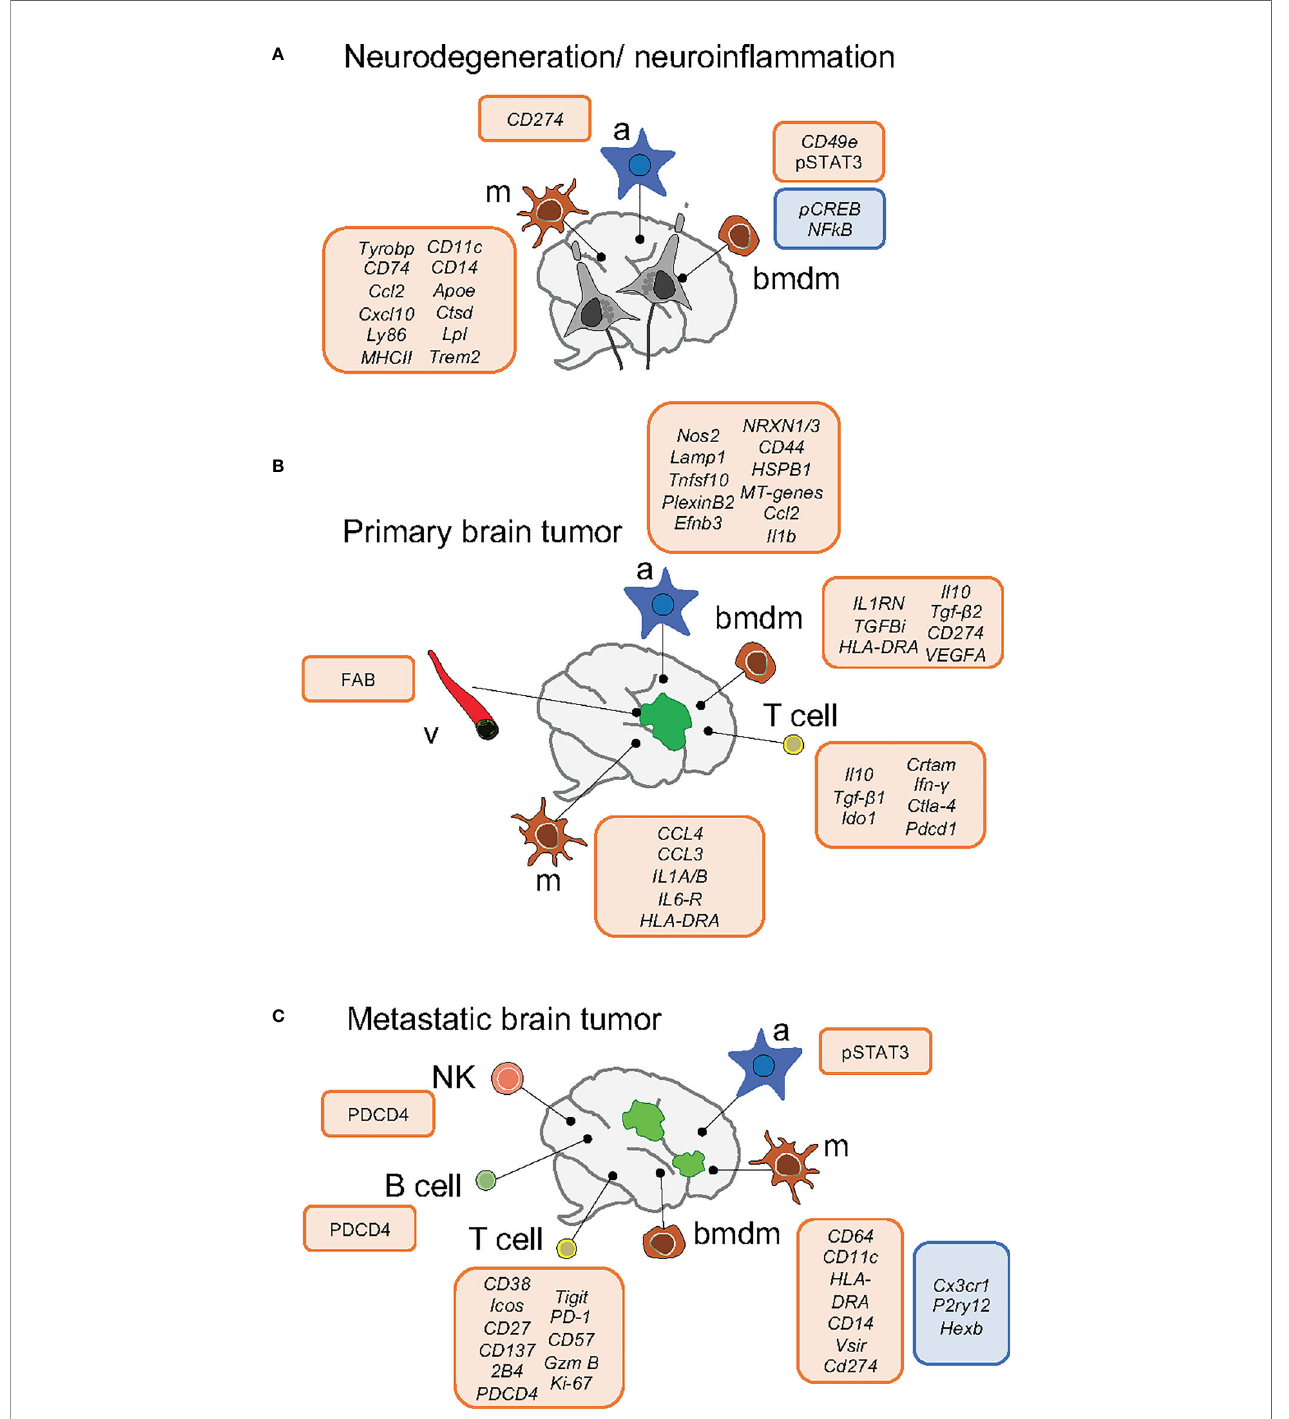
FIGURE 1 | Schema of key markers deregulated within the brain microenvironment in neurodegeneration/neuroin fl ammation (A) and primary (B) and secondary (C) brain tumors. Upregulation is indicated by the box in red and downregulation by the box in blue. Neurodegeneration/neuroin fl ammation comprises the following brain disorders: Alzheimer, Huntington disease, Amyotrophic Lateral Sclerosis and Experimental Autoimmune Encephalomyelitis. a, astrocytes; m, microglia; bmdm, bone marrow-derived macrophages; v,